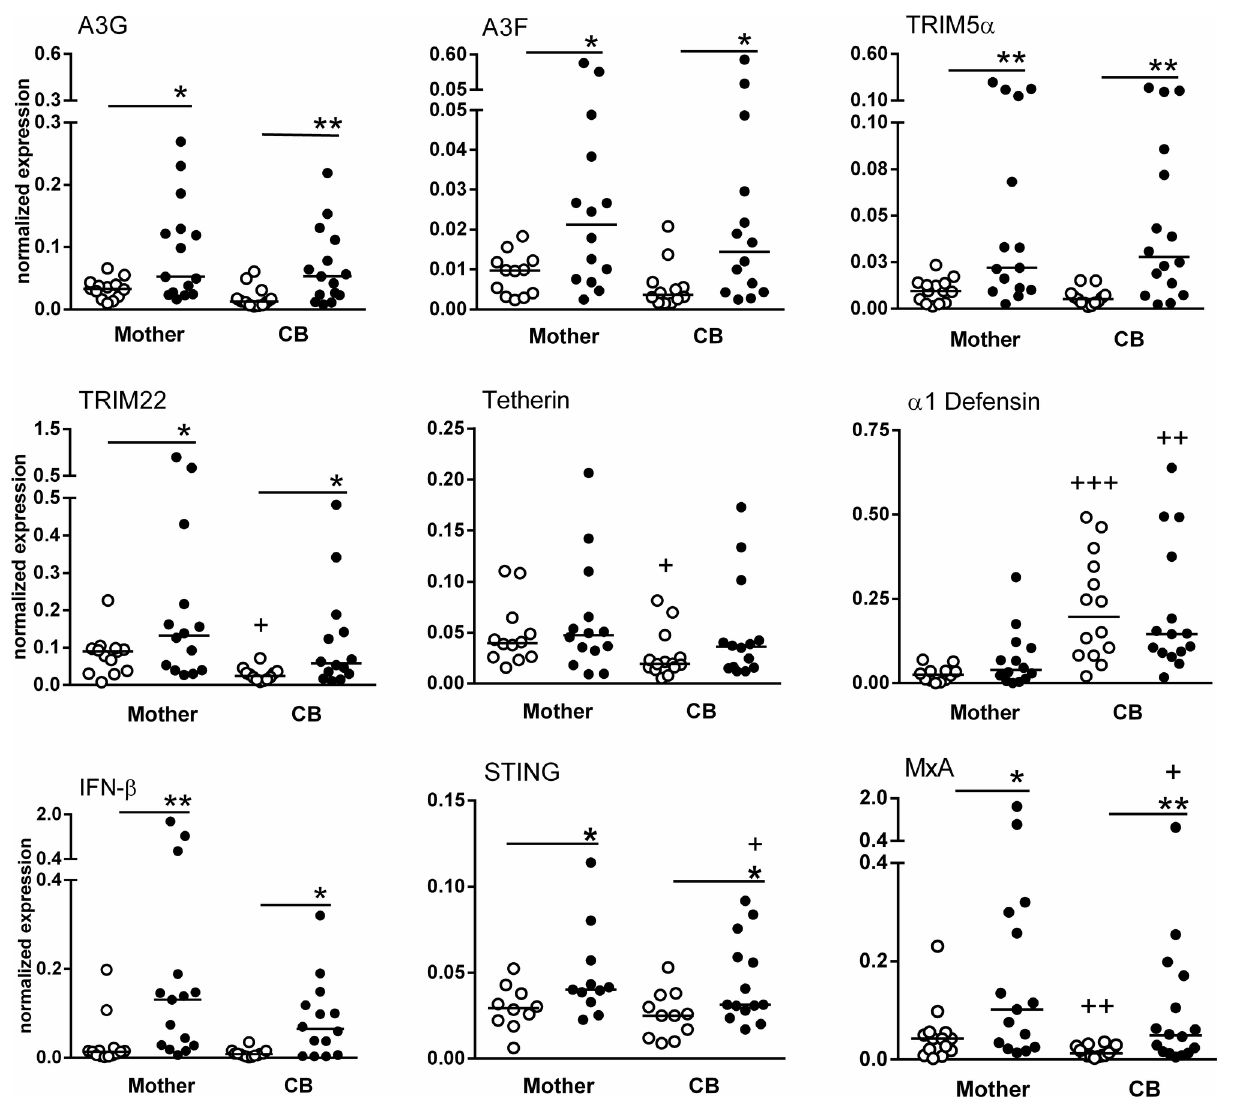
Figure 1. Upregulation of antiviral restricting factors in the MNCs of HIV-infected mothers and CB samples. The mRNA expression levels of antiviral factors, such as A3G, A3F, TRIM-5α, TRIM22, tetherin, α1-defensin, IFN-β, STING and MxA, in MNCs from HIV-infected mothers (closed symbols) (n=15) and corresponding CB (n=16) and in MNCs from UN mothers (open symbols) (n=13-14) and corresponding CB (n=11-13) were evaluated by real-time PCR. The data represent median values. *p≤0.05, **p≤0.01 compared with the control group; +p≤0.05, ++p≤0.01, +++p≤0.001 compared with the mother group. doi: